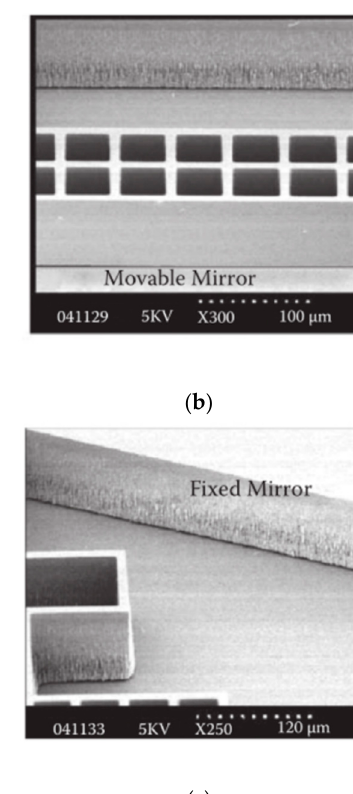
( b ) Figure 10. On-chip in-plane electrostatic comb-based FTS: ( a ) Comb-drive actuator; ( b ) optical components. (Reprinted with permission from Reference [35] IEEE). Eltagoury et al. developed a cascaded low-finesse Fabry-Perot interferometers based FTS (see Figure 11) in 2016 [36]. Two Fabry-Perot interferometers were applied to replace a traditional Michelson interferometer in this system. A fixed Fabry-Perot interferometer was a silicon block that could generate spectral modulation, and thus, creating a shifted version of the interferogram away